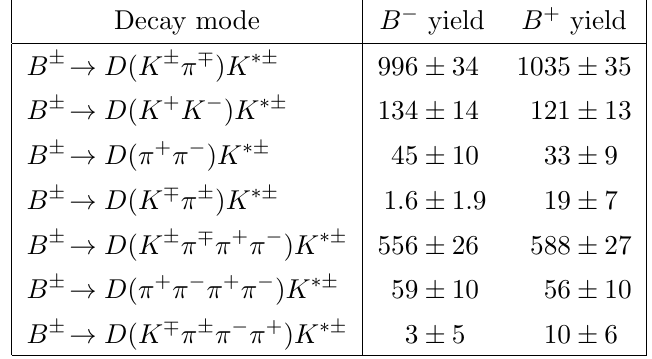
Table 1. Fitted yields in each of the B decay modes. The uncertainties are statistical only.